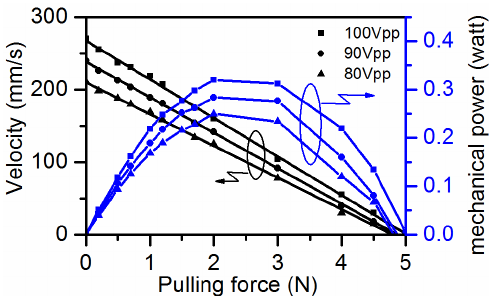
Figure 14. Velocity vs. pulling force at various voltages.